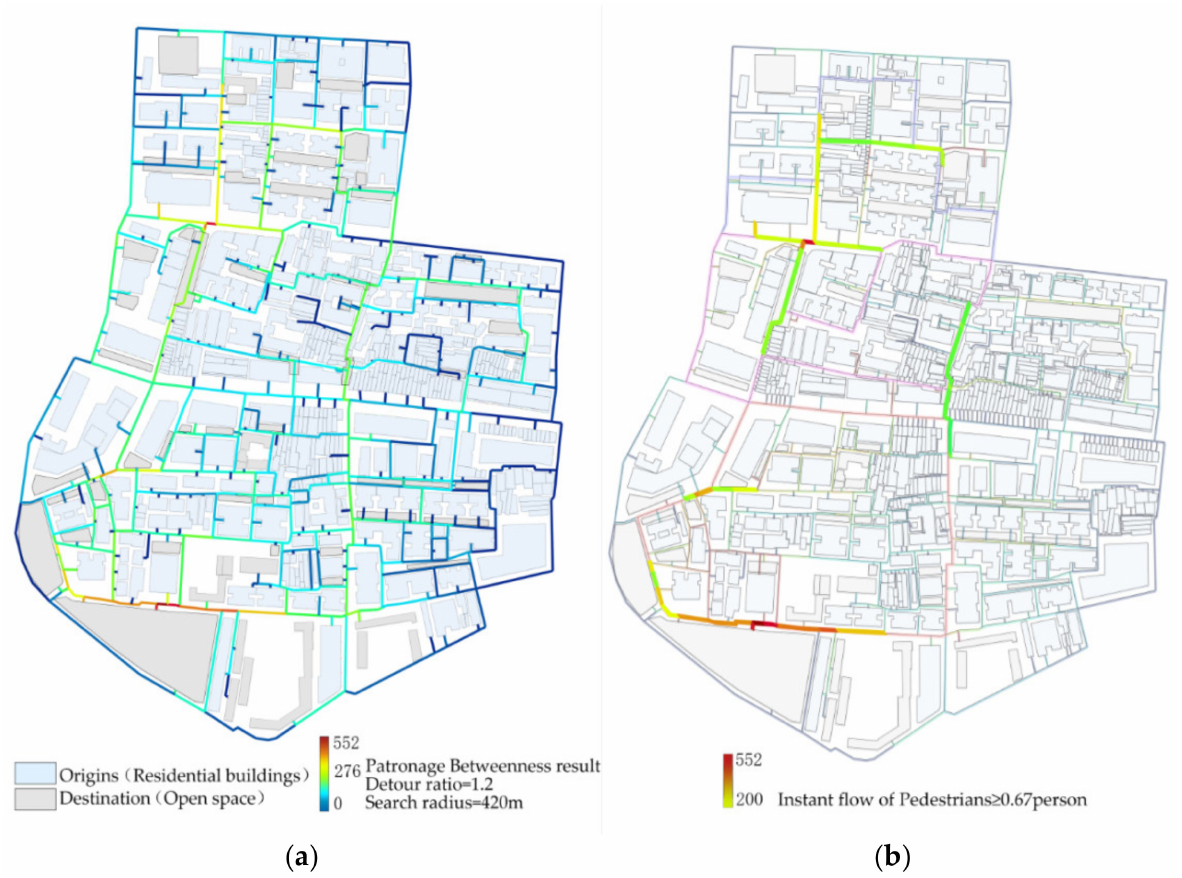
Figure 12. ( a ) Pedestrian flow rates of the young and middle-aged people; ( b ) crowded pedestrian routes for the young and middle-aged